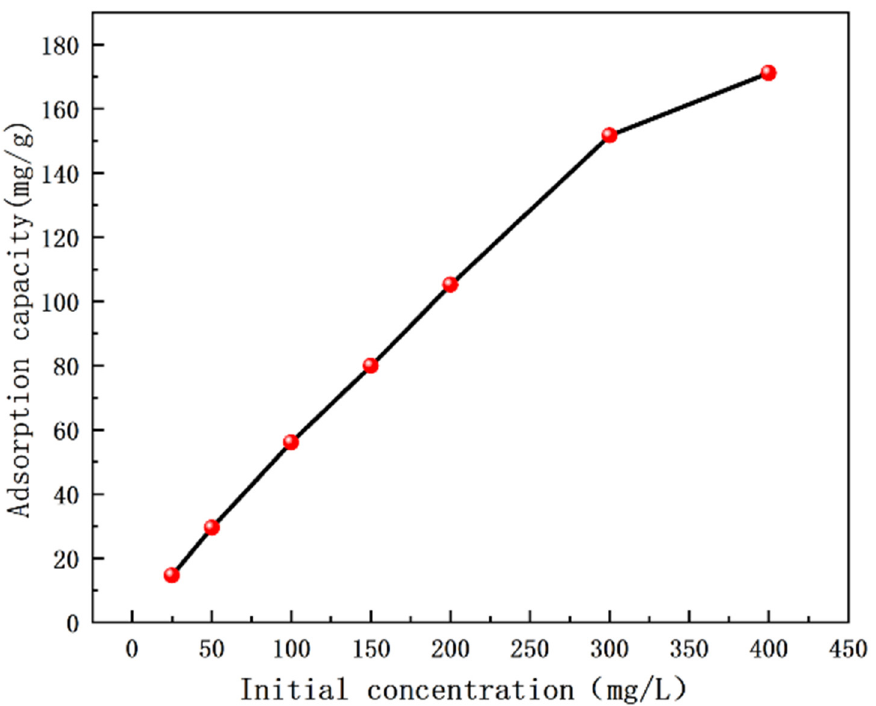
Figure 8. Effect of initial concentration of Cr(VI) aqueous solution on the adsorption capacity of PVDF–2GO@GO nanofibrous membranes.